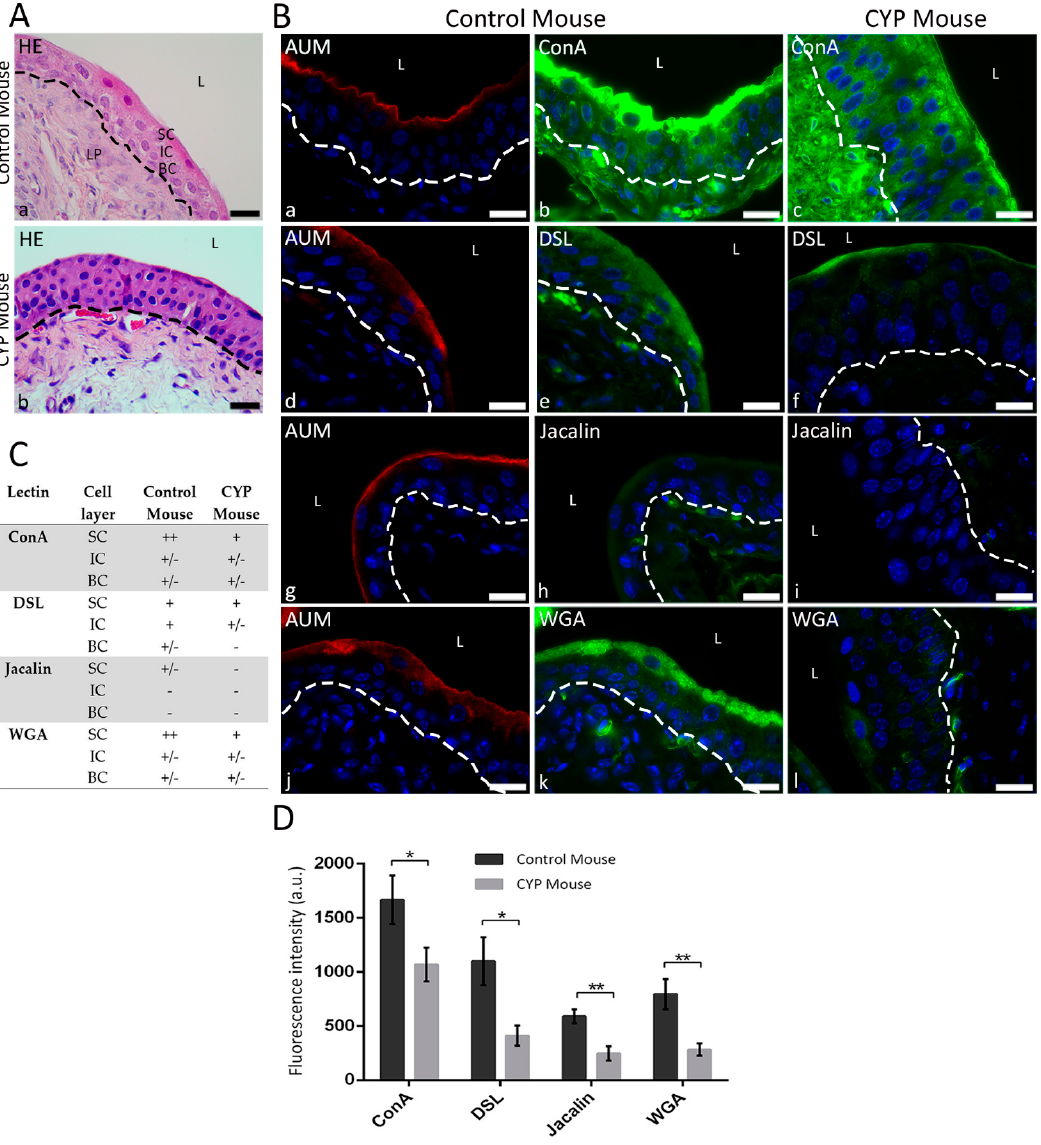
Figure 3. Lectin binding to control and CYP-treated mouse urothelium. ( A ) Representative photomicrographs of HE-stained paraffin sections ( a , b ). ( B ) Representative photomicrographs of AUM immunolabeling (red fluorescence) and lectin fluorescence (green) in normal ( a , b , d , e , g , h , j , k ) and CYP-treated mouse urothelium ( c , f , i , l ). ConA labeling is present in all cells of control and CYP- treated urothelium with very intense labeling in the cytoplasm of SC ( b , c ). DSL binds to all cell layers of control urothelium, whereas in CYP-treated tissue the labeling is limited to the apical sur- face of SC ( e , f ). Jacalin binds weakly to the cytoplasm of SC in control urothelium, whereas in the CYP-treated urothelium the Jacalin binding is almost completely absent ( h , i ). Very intense WGA binding is present in the cytoplasm of SC, while the binding is weak in IC and BC of normal mouse urothelium. After treatment with CYP, fluorescence intensity is decreased in SC layer, while IC and BC continue to show weak WGA binding ( k , l ). ( C ) Semi-quantitative analysis of lectin binding to urothelial cells per cell layer (SC, superficial cells; IC, intermediate cells; BC, basal cells). Binding of lectins is scored as ++ (very intense), + (intense), +/ − (weak) and − (very weak). ( D ) Fluorescence